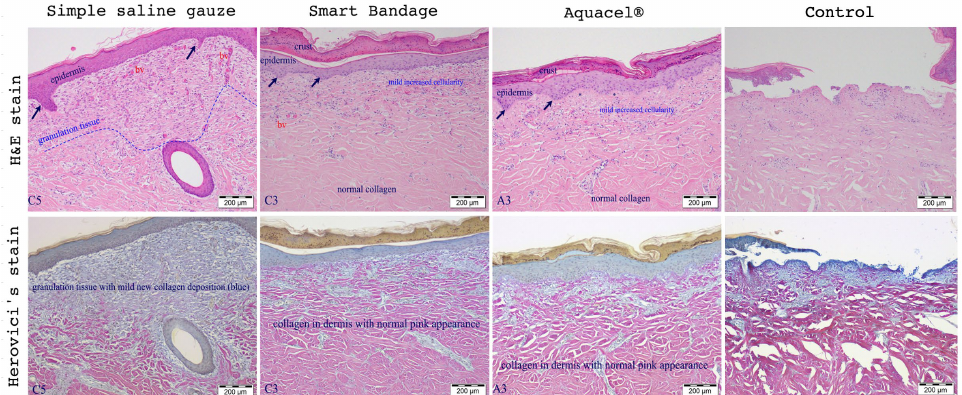
Figure 2. Histological representative wounds (out of a total n = 6) were evaluated on day 17 and treated with simple saline gauze, Smart Bandage (INTELIGELS Ltd. Hoshaya, Israel), and Aquacel ® . Hematoxylin, eosin (H&E), and Herovici’s stains were used to evaluate wound healing and reactive fibrosis. Simple saline gauze showed less favorable results, while Smart Bandage (INTELIGELS Ltd. Hoshaya, Israel) and Aquacel ® perform very similarly and favor wound healing. Simple saline gauze increased fibrosis compared to the Smart Bandage (INTELIGELS Ltd. Hoshaya, Israel) and Aquacel ® . Arrows indicate epidermal hyperplasia and the formation of rete pegs, which appear slightly increased in the simple saline gauze. The simple saline gauze dressing is associated with increased granulation tissue/fibrosis compared to the Aquacel ® /Smart Bandage (INTELIGELS Ltd. Hoshaya, Israel). Control represents a partial-thickness burn done at day 0 and taken to histological evaluation. There is thermal necrosis of the epidermis and dermis and a focal sloughing of the necrotic epidermis; no evidence of regeneration or inflammation is evident.